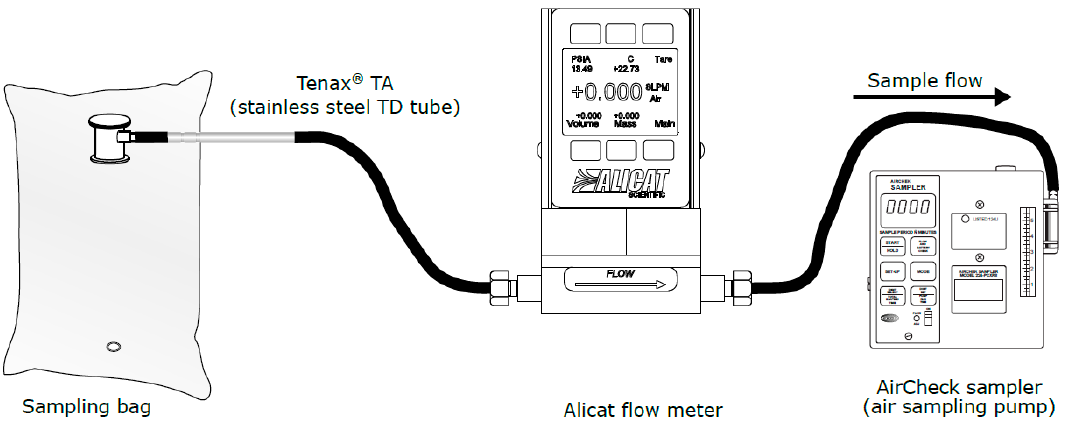
Figure 3. Sampling method 3—Sampling pump method.